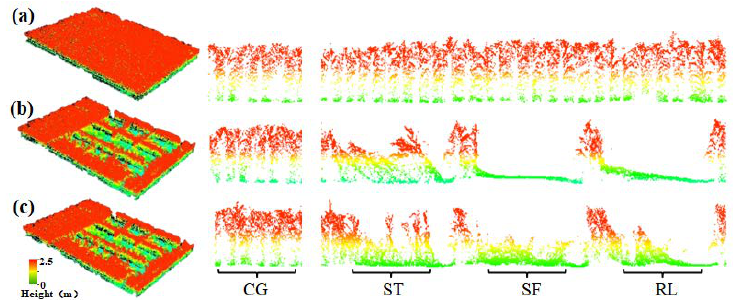
Figure 7. Experimental area profile. ( a ) No lodging. ( b ) After artificial lodging. ( c ) Lodging for a period of time. Note: CG: control group; ST: stem tilt; SF: stem folding; RL: root lodging.